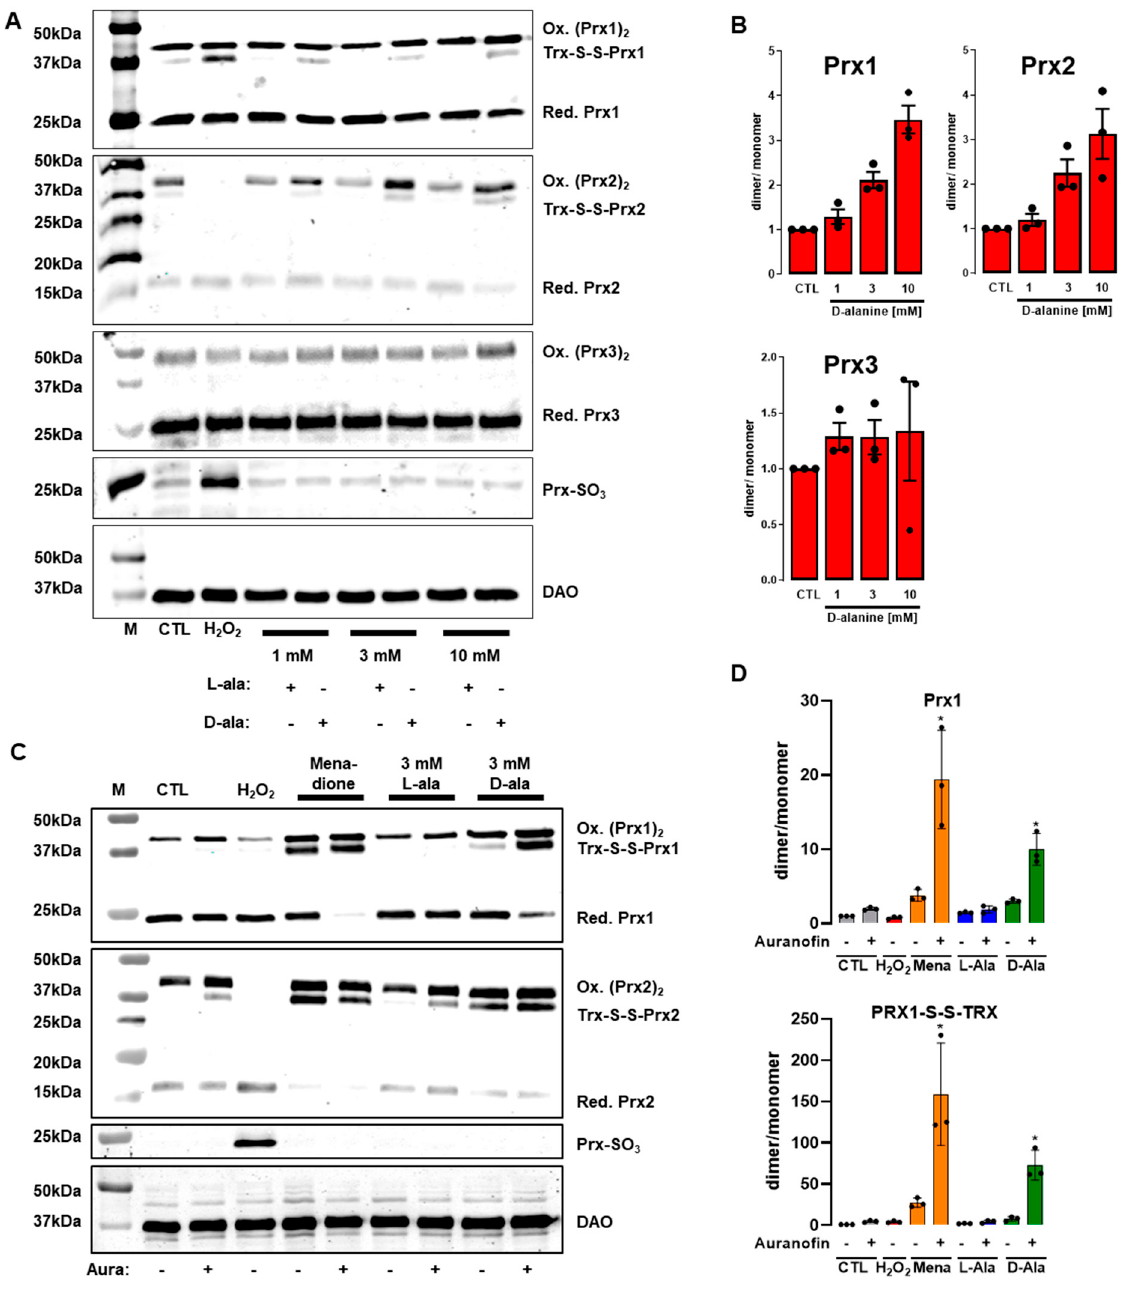
Figure 5. Oxidation of peroxiredoxins (Prx) in response to exogenous or DAO-derived H 2 O 2 or menadione. ( A ): Representative redox western blot (30 µ g protein) for Prx1, Prx2, Prx3, and Prx-SO 3 after stimulation with different concentration of D- or L-Ala in HUVEC. ( B ): Quantification of redox- western blots by densitometry ( n = 3). ( C ): Redox western blot and quantification ( D ) for Prx1 and Prx2 with HUVEC-DAO pre-incubated with auranofin (20 min, 3 µ M) prior D- or L-ala stimulation, * p < 0.05 as compared to CTL with auranofin. One-way-ANOVA with Bonferroni correction.